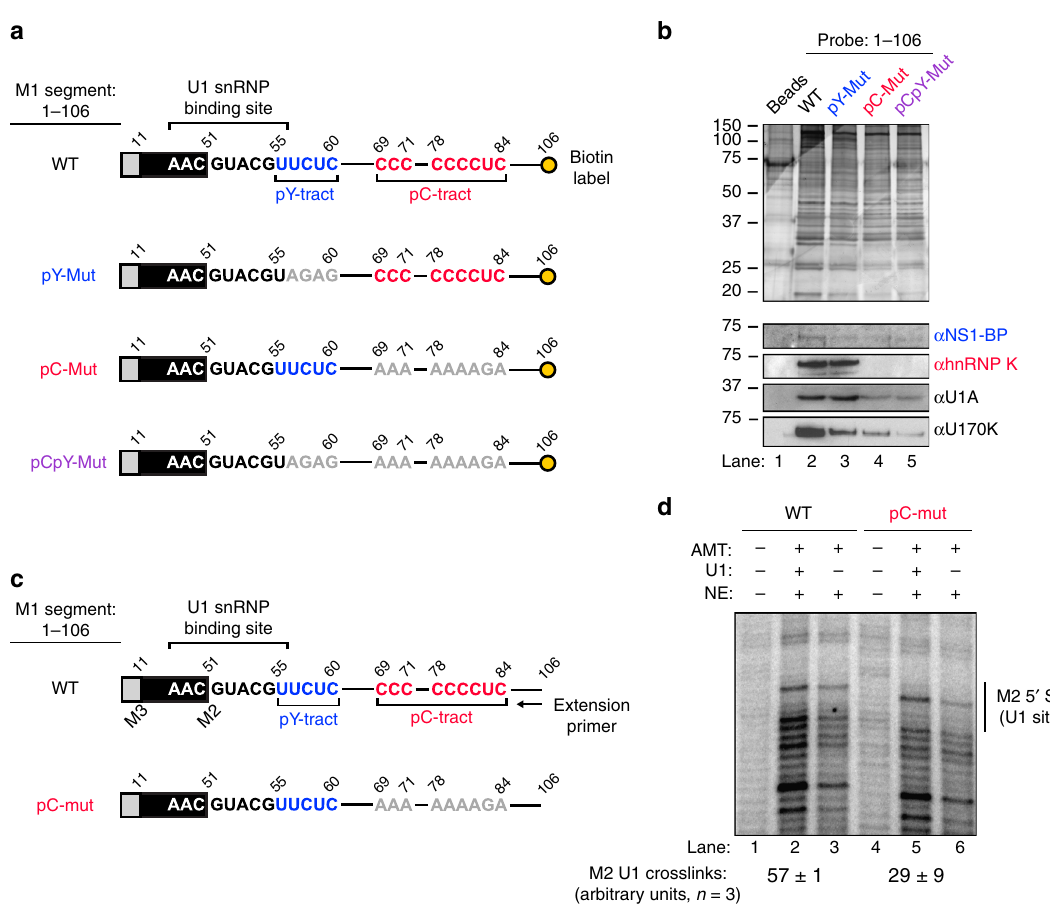
Fig. 3 hnRNP K binding site promotes U1 snRNP binding. a Diagram of in vitro transcribed, biotinylated RNA af fi nity baits derived from IAV M segment mRNA. Blue text corresponds to NS1-BP binding, red text corresponds to hnRNP K binding, based on data from Fig. 2. Grey text corresponds to mutated nucleotides. b RNA af fi nity puri fi cation of proteins bound to baits: 1 – 106 WT, 1 – 106 pY-mut, 1 – 106 pC-mut, 1 – 106 pCpY-mut. RNA probes were incubated in JSL1 nuclear extract and isolated with streptavidin beads. Bead eluates were resolved via SDS-PAGE and either silver stained (top panel) or immunoblotted for speci fi c proteins (bottom panels). Molecular weights are indicated to left of each blot. c Diagram of in vitro transcribed AMT psoralen cross-linking substrates derived from IAV M segment mRNA. Position of extension primer is shown below. d Radiolabeled primer extension of M segment RNA substrates after AMT psoralen cross-linking. RNA substrates were incubated with JSL1 nuclear extract ± presence of U1 snRNP, supplemented with AMT psoralen, and irradiated with 365 nm UV light. Cross-link products were visualized by primer extension. Identity of cross-link products was determined using dideoxy sequencing (Supplementary Fig. 3). M2 U1 crosslinking quanti fi cation is in arbitrary units representing the signal of bands at the M2 5´ss in the presence of U1 ( + U1) divided by the sum of bands in the presence and absence of U1. Values are means ± s.d. from three independent experiments. Uncropped gels shown in Supplementary Fig.